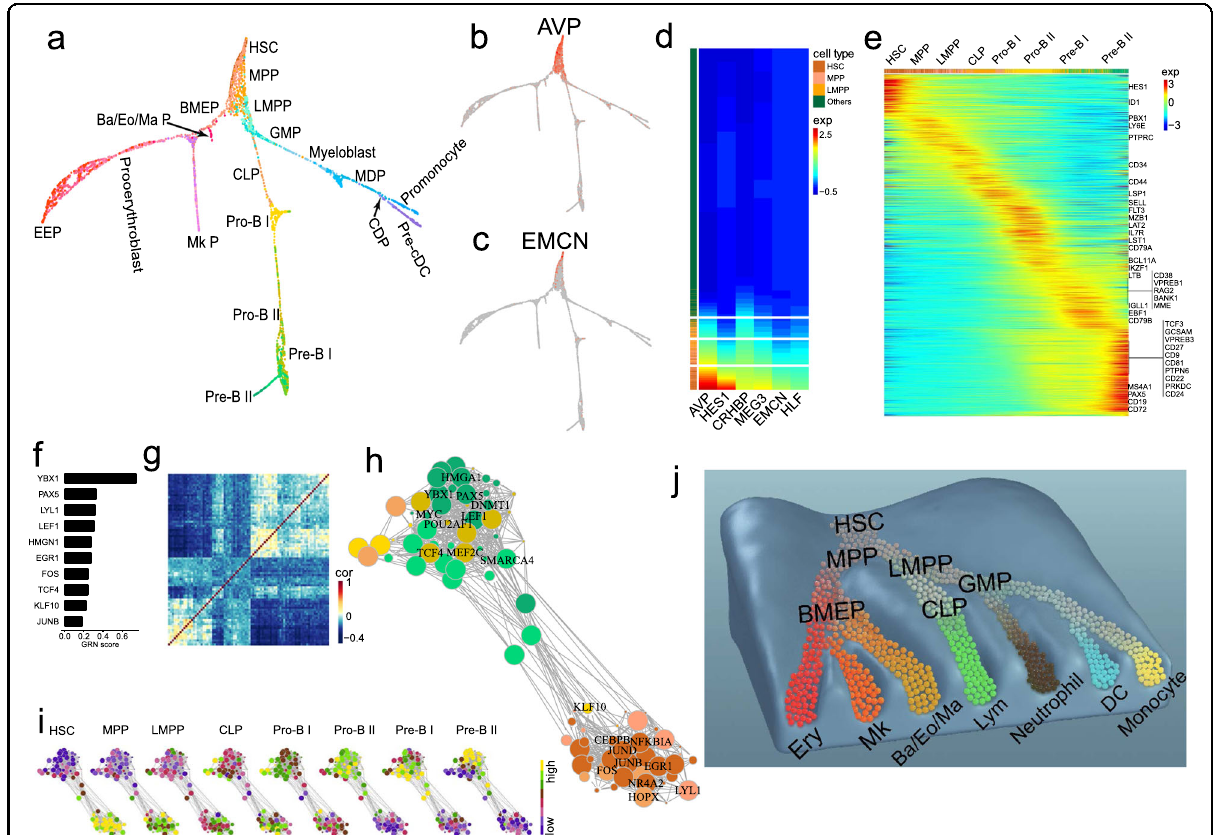
Fig. 2 Hematopoietic cell lineages and hierarchically continuous transition model for hematopoiesis. a Hematopoietic lineages visualized by SPRING, with cells colored by cell type as in Fig. 1e. b , c Expressions of AVP (b) and EMCN (c) are decreasing along hematopoietic lineages. d Heatmap of normalized expression level of early hematopoietic markers along lineages. e Heatmap of transcriptomic dynamics during lymphopoiesis. f – i Coordinated TFs and networks underlying lymphoid lineage. The top 10 coordinated TFs ( f ); correlation of the coordinated TFs ( g ); network of coordinated TFs, in which the size of each node represents the magnitude of expression ( h ); dynamics of TFs expression in regulatory networks along lymphoid lineage ( i ), in which each node was colored by average expression level. j Hierarchically continuous transition model for